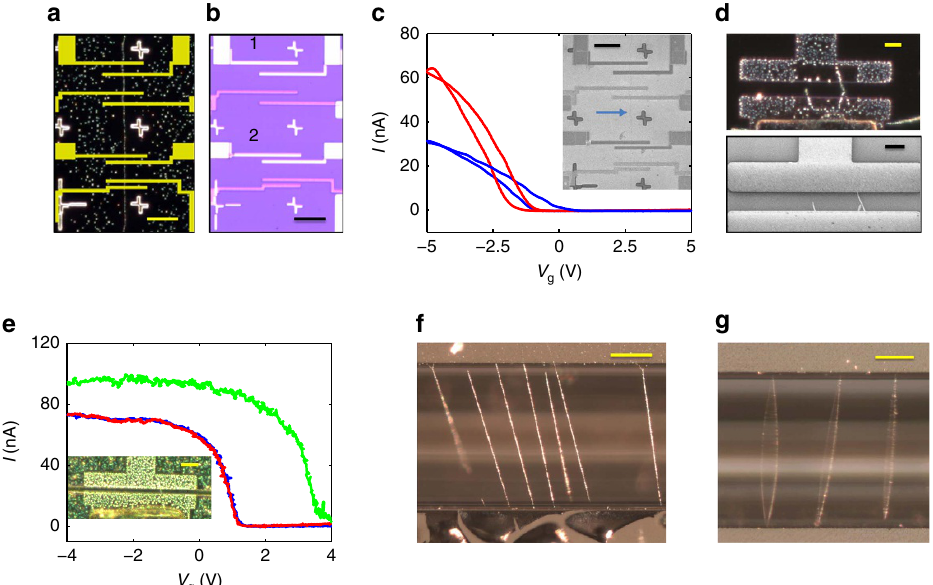
Figure 4 | Optically imaging of on-surface and suspended carbon nanotube devices. ( a ) Dark-field optical microscopy image of marked carbon nanotube (CNT) with p -nitrobenzoic acid ( p NBA) nanocrystals (NCs), and overlay of the lithography circuit design. Scale bar is 10 m m. ( b ) Optical image of the complete fabricated device. The two different colour electrodes are two different metallic contacts. Scale bar is 10 m m. ( c ) Transfer characteristic of the two CNTs devices 1 (blue), and 2 (red). Inset: SEM image of the completed circuit. Blue arrow points towards the CNT that was marked in ( a ). Scale bar, 10 m m. ( d ) Top: Dark field optical microscopy image of marked junction. Bottom: SEM image of the same junction. Scale bar in both images is 3 m m. ( e ) Main panel: Transfer characteristic of suspended CNT before p NBA deposition (blue), immediately after deposition (green), and after cleaning process (red). Inset: Dark field optical microscopy image of the measured junction marked with p NBA NCs. Scale bar, 3 m m ( f , g ) Dark field optical images of long suspended CNTs decorated with p NBA NCs. Scale bar, 50 m